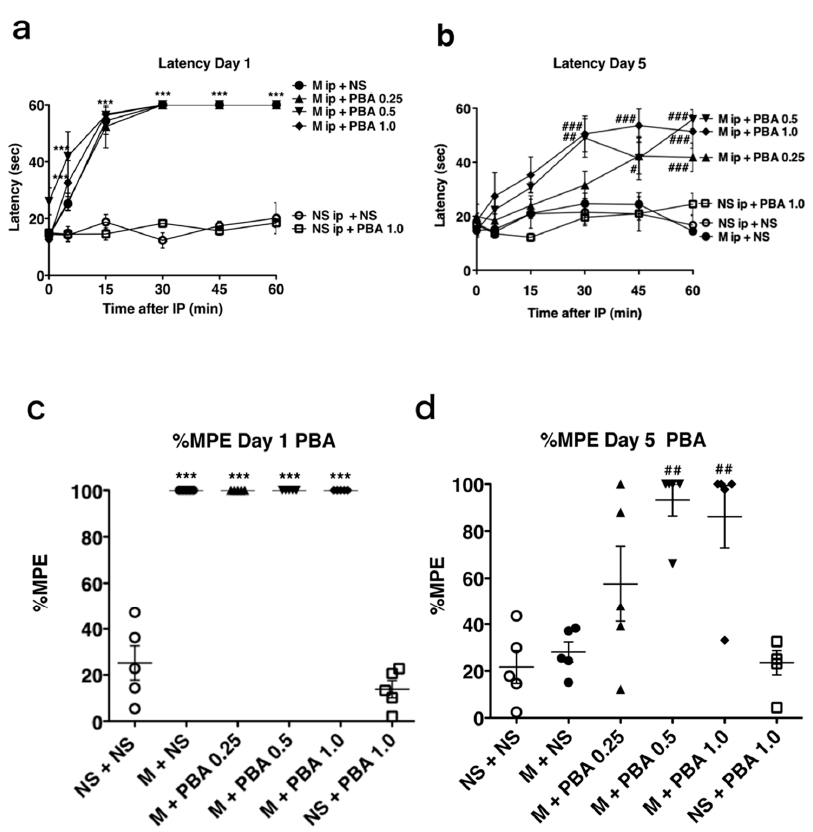
Figure 2. The pharmacological ER chaperone PBA attenuated morphine tolerance development. ( a , b